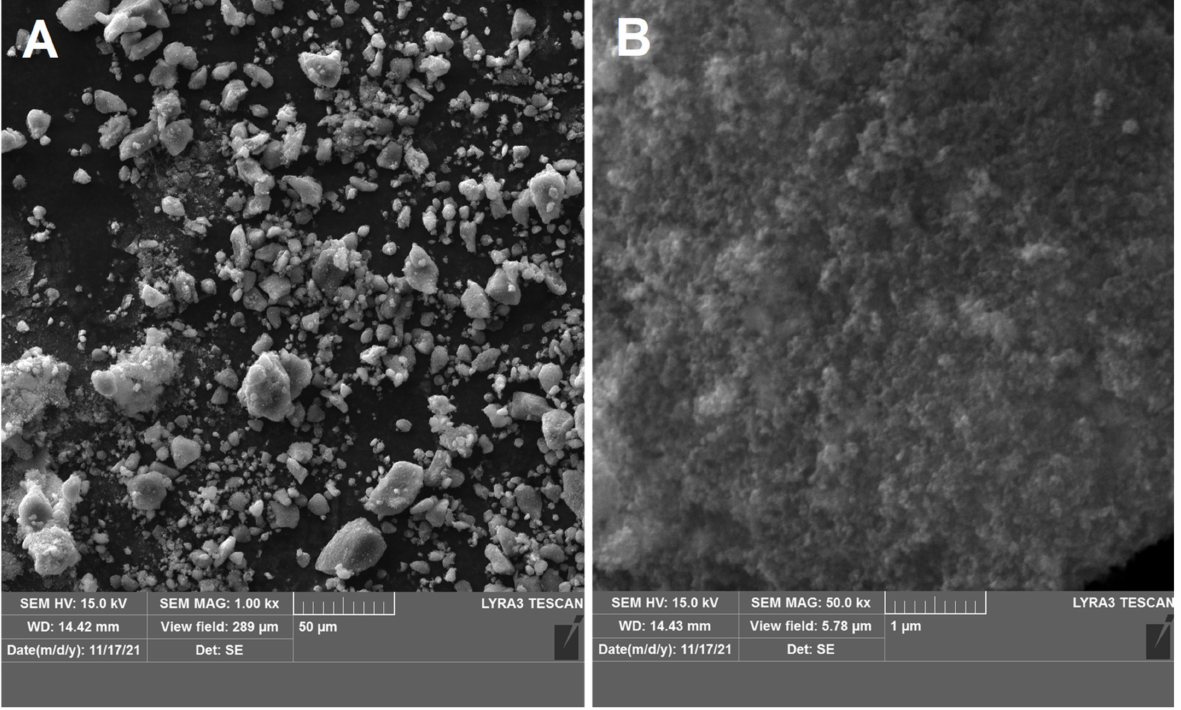
Figure 3. SEM images of the Pt/75BP electrocatalyst at lower and higher magnifications ( A , B